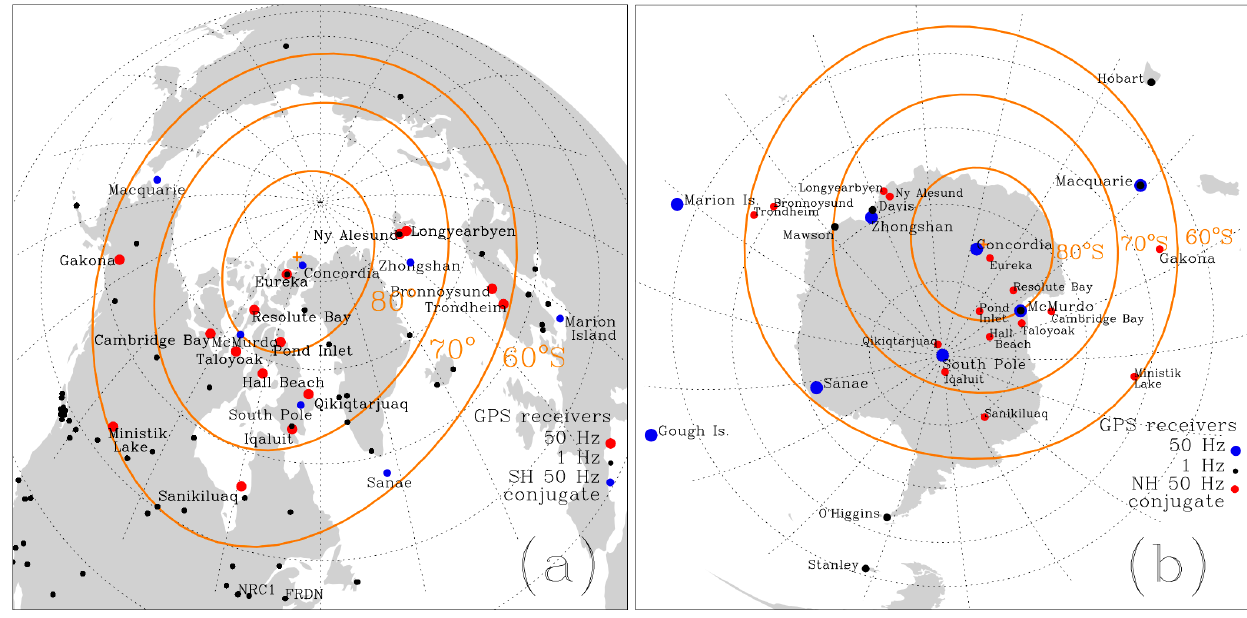
Figure 1. The GISTM arrays complemented by geodetic-quality 1Hz GPS receivers (black dots) in the (a) northern and (b) southern high latitudes. The northern GISTMs (red dots) and southern GISTMs (blue dots) are also shown at their conjugate locations in the opposite hemispheres. The altitude-adjusted corrected geomagnetic (AACGM) latitudes 60, 70 and 80 ◦ , in yellow, are superposed over the geographic